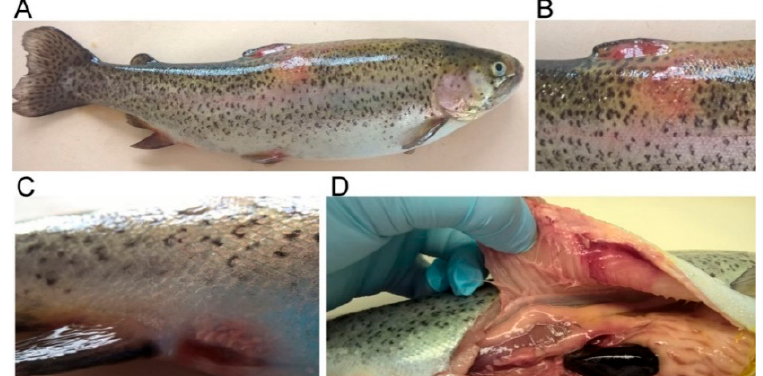
Figure 2. A rainbow trout individual with symptoms of septicemia caused by natural infection with A. salmonicida subsp. salmonicida . ( A ) In addition to the conspicuous redness and hyperemia of the skin, ruffled scales, swelling and petechias at the base of the dorsal ( B ), ventral, and both pelvic fins, a distended anus ( C ), and a few dermal ulcers, symptoms of systemic infection such as exophthalmia and swelling of abdomen were observed. ( D ) Anemia in internal organs, enlarged spleen and liver, ascitic fluid in peritoneal cavity, and lysis of tissues, the consequence of which was visible as bones sticking out from the